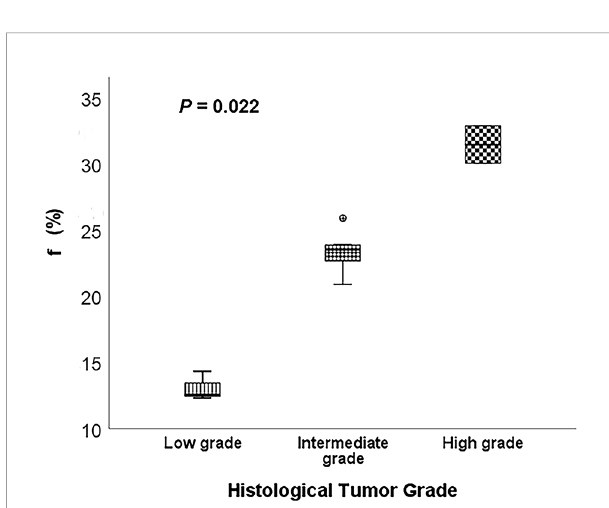
FIGURE 4 | Comparison of the f between different histological tumor grades using the Kruskal-Wallis